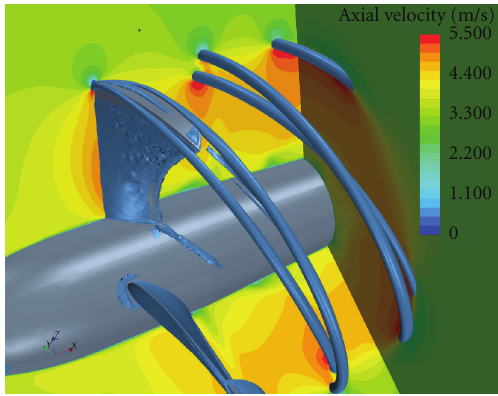
Figure 20: Vortical structures at the propeller tip. Q-factor visuali-